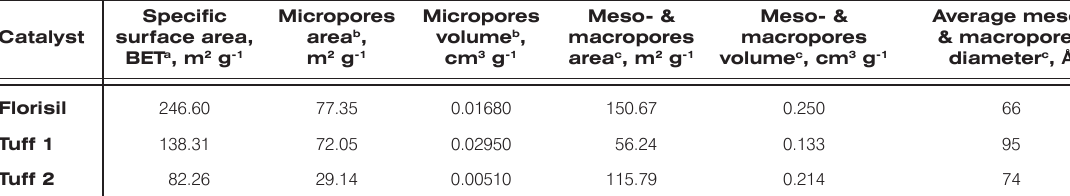
Table 1. Surface area and porosity characteristics of the studied catalysts.